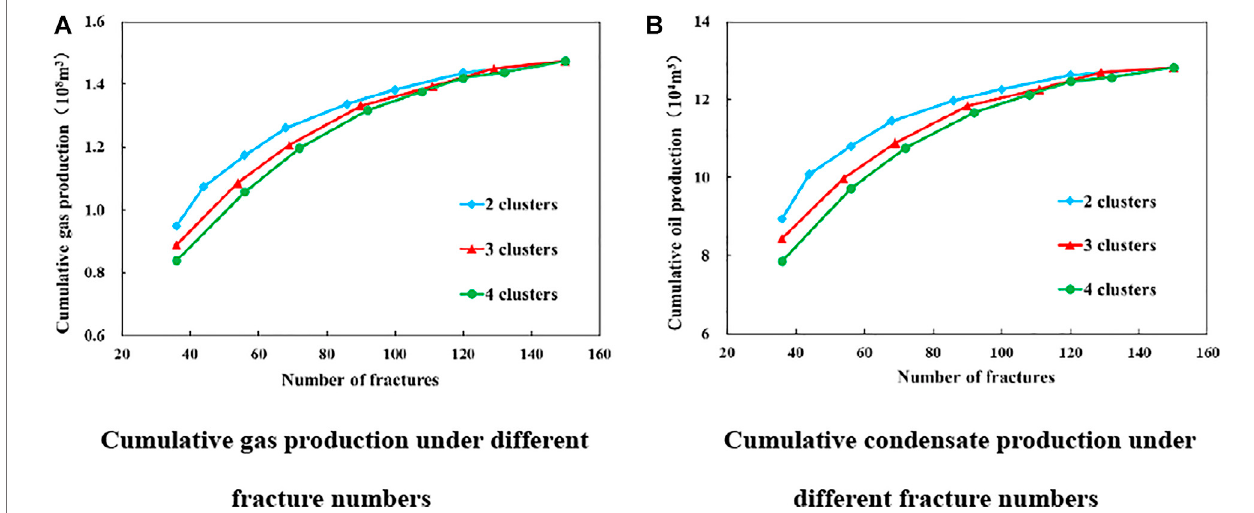
FIGURE 6 | Cumulative gas and condensate production curves of different numbers of fractures.